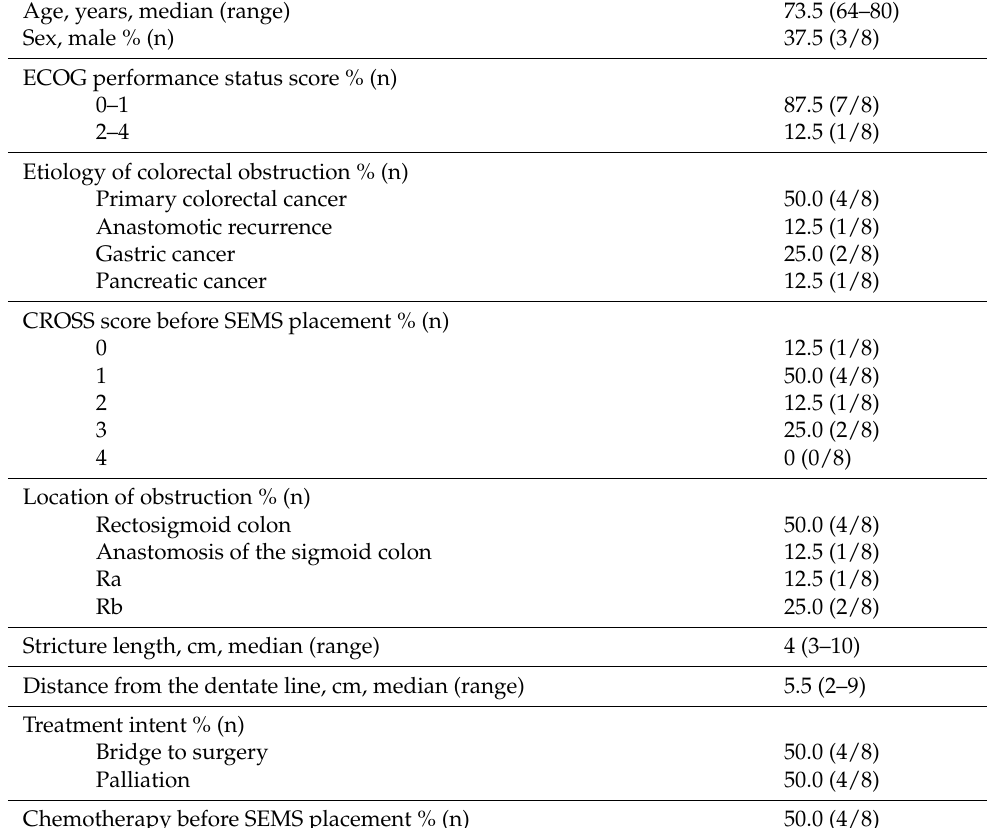
Table 1. Patient and tumor